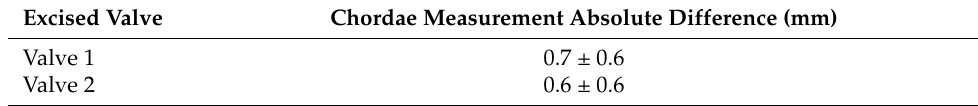
Figure 7. Side-by-side volume rendered comparisons from multiple view points of the CT data ( top ) and compounded echo ( bottom ). Table 1. Volume comparison metrics between compounded echo and CT.